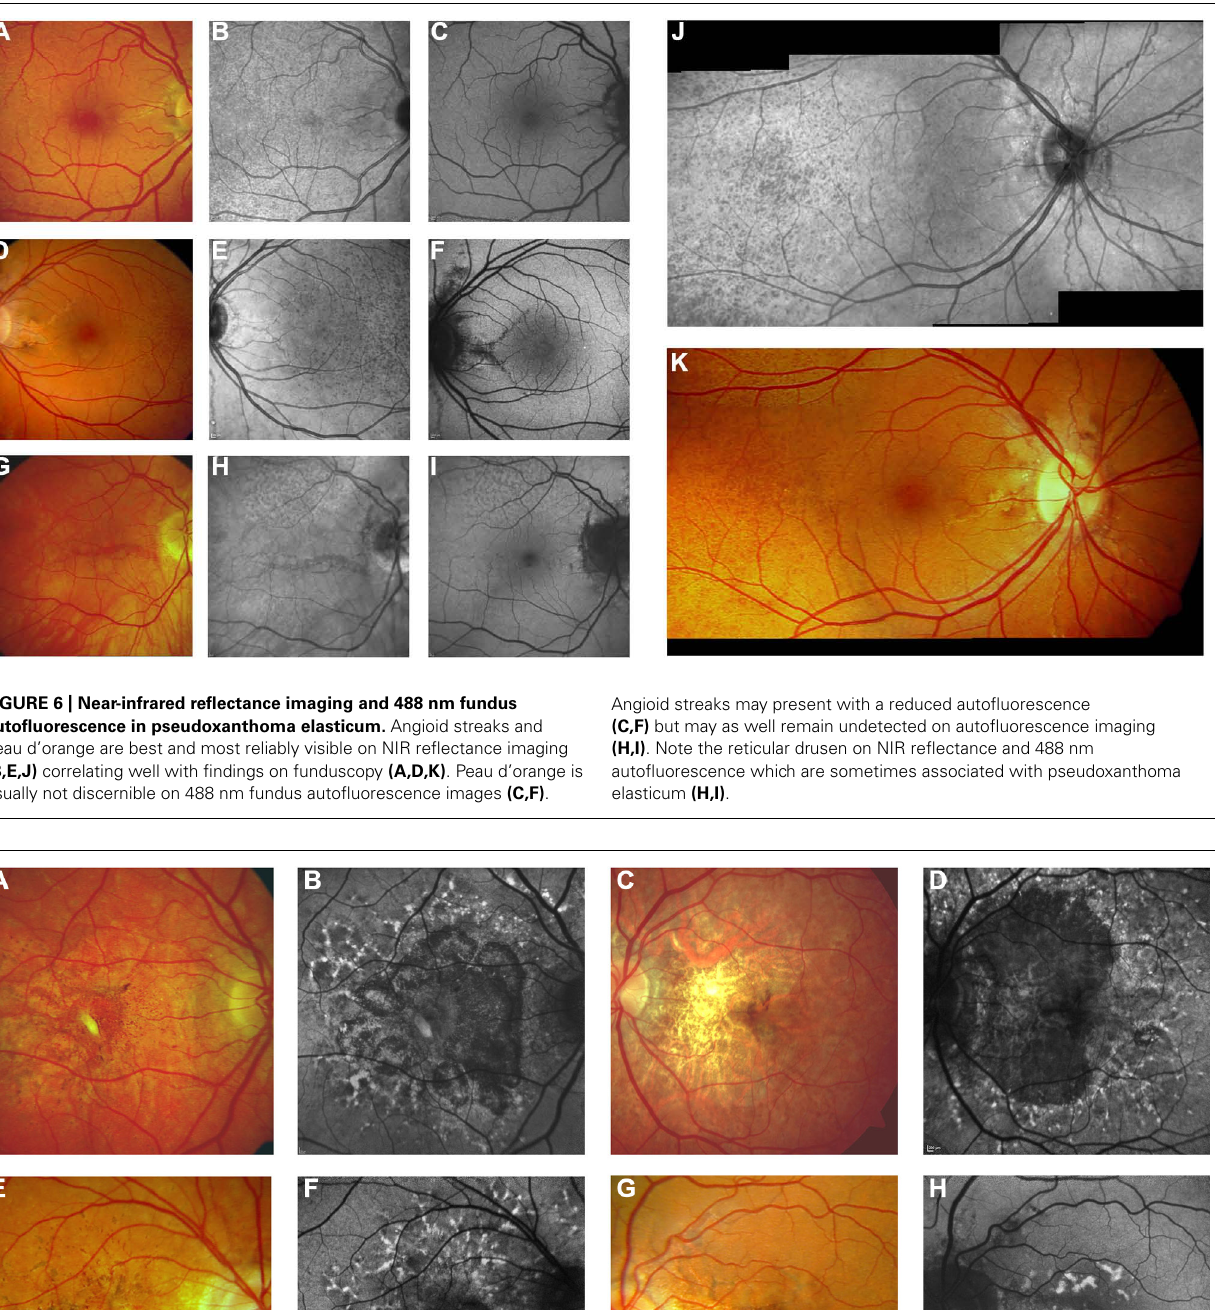
FIGURE 7 | Pattern dystrophy-like changes and atrophy in pseudoxanthoma elasticum on 488 nm fundus autofluorescence imaging. Atrophic lesions and pattern dystrophy-like changes are typical features of advanced pseudoxanthoma elasticum. Compared to funduscopic images (A,C,E,G) these lesions are best visible on